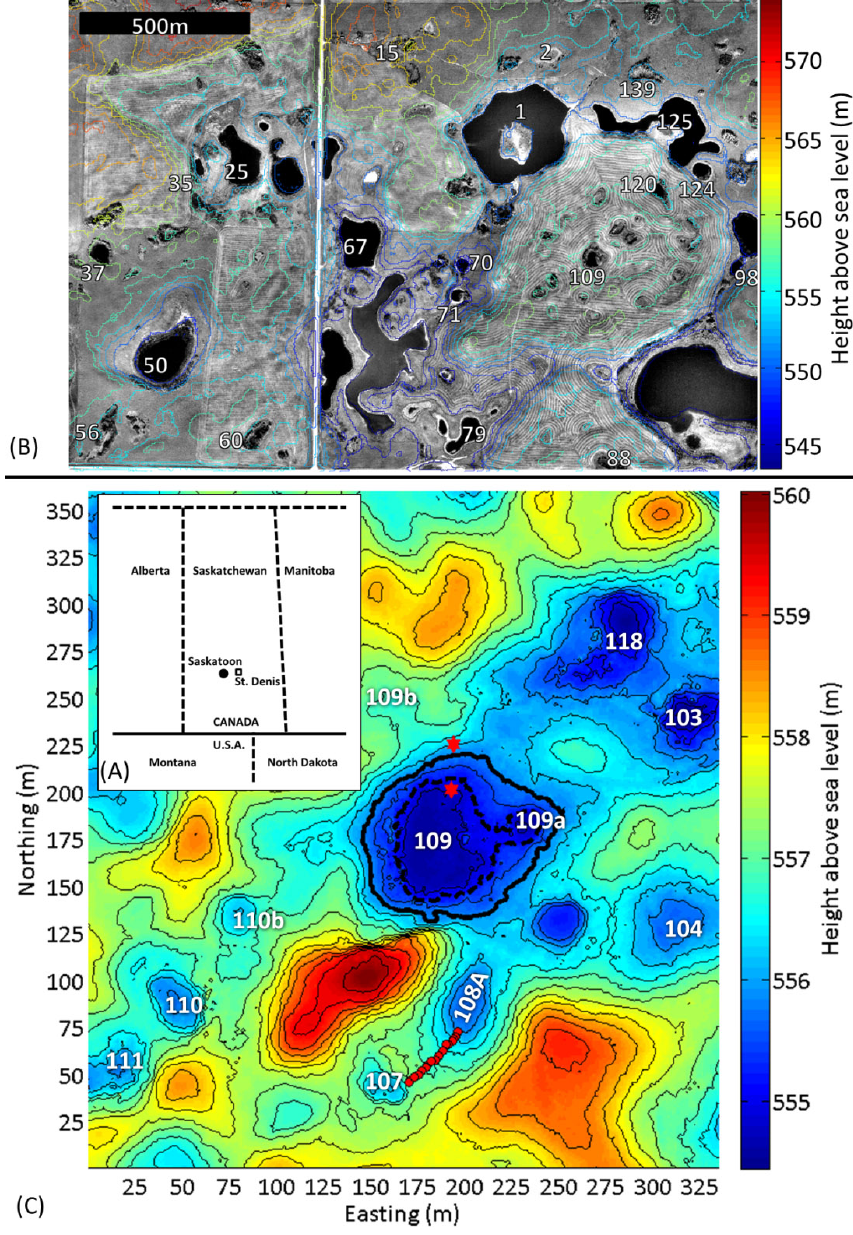
Fig. 1. (A) Regional location of the St. Denis National Wildlife Area; (B) St. Denis NWA site; (C) enlargement of pond 109 area. In (C) the dots between pond 107 and 108A indicate the location where salinity and groundwater levels were measured along the transect. Stars represent piezometers; the thick solid line around pond 109 indicates the water margin of the pond in July 2012; the dashed line at pond 109 indicates the average location of the pond 109 water margin. White numbers indicate selected